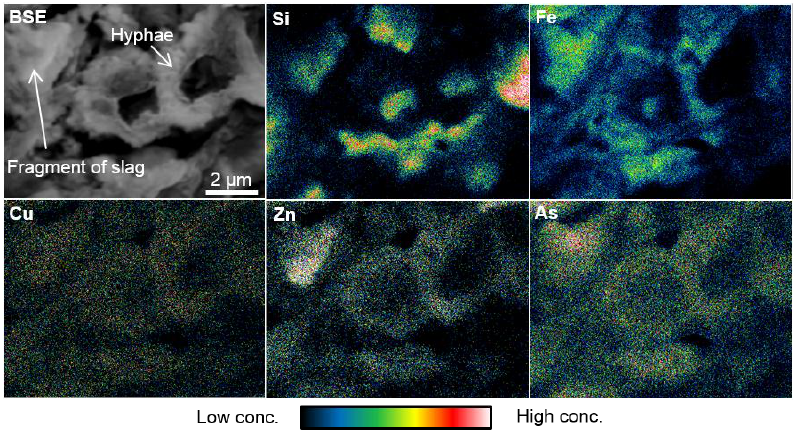
Figure 7. A back-scattered electron image and the elemental maps of the lichen